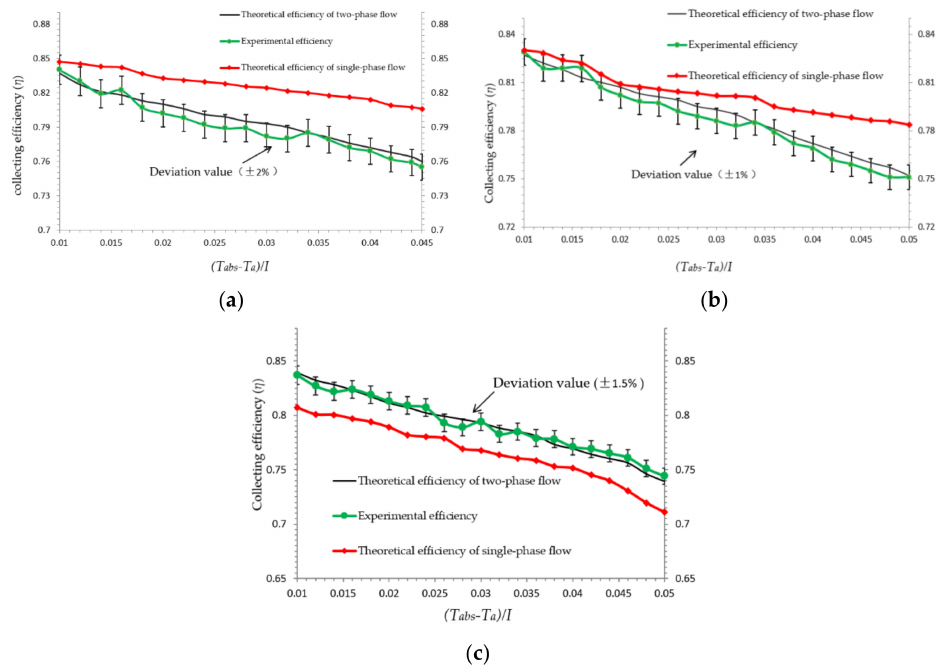
Figure 14. Experimental and theoretical e ffi ciency curves with di ff erent flow rates; ( a ) Flow rate of 8.8 kg / h; ( b ) Flow rate of 4.4 kg / h; ( c ) Flow rate of 2.6 kg / h.